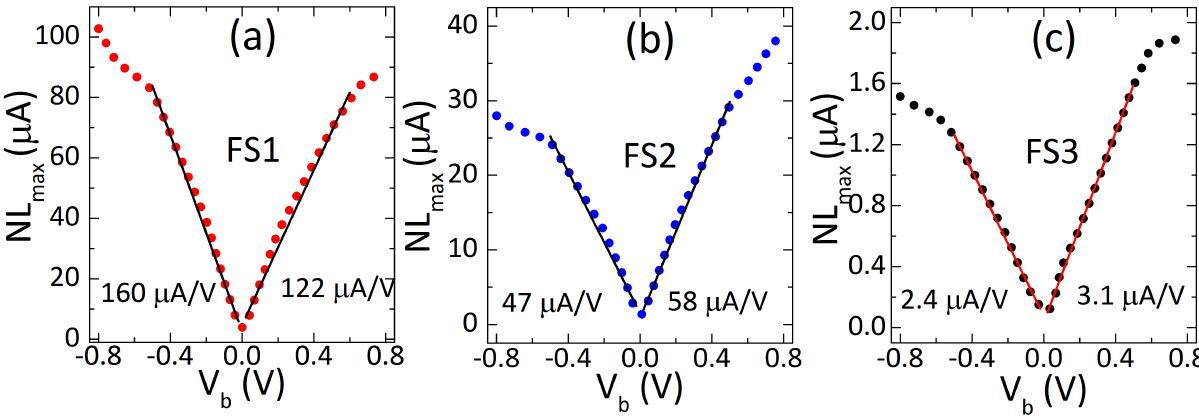
Figure 3. Influence of bias voltage on maximal nonlinearity (NLmax) of high ( a ), medium ( b ) and low ( c ) sensitivity sensors. The nonlinearity is expressed as the maximal residual of linear fit to the transfer curves of the sensors. The nonlinearity increases approximately linearly up to a certain bias, but with a higher rate under positive polarity. It also reaches a higher maximum value under negative polarity. The linear ranges of the nonlinearity were determined by fitting the linear model to the measured data using the least squares method. Solid lines represent the linear fits and the dotted lines are the experimental